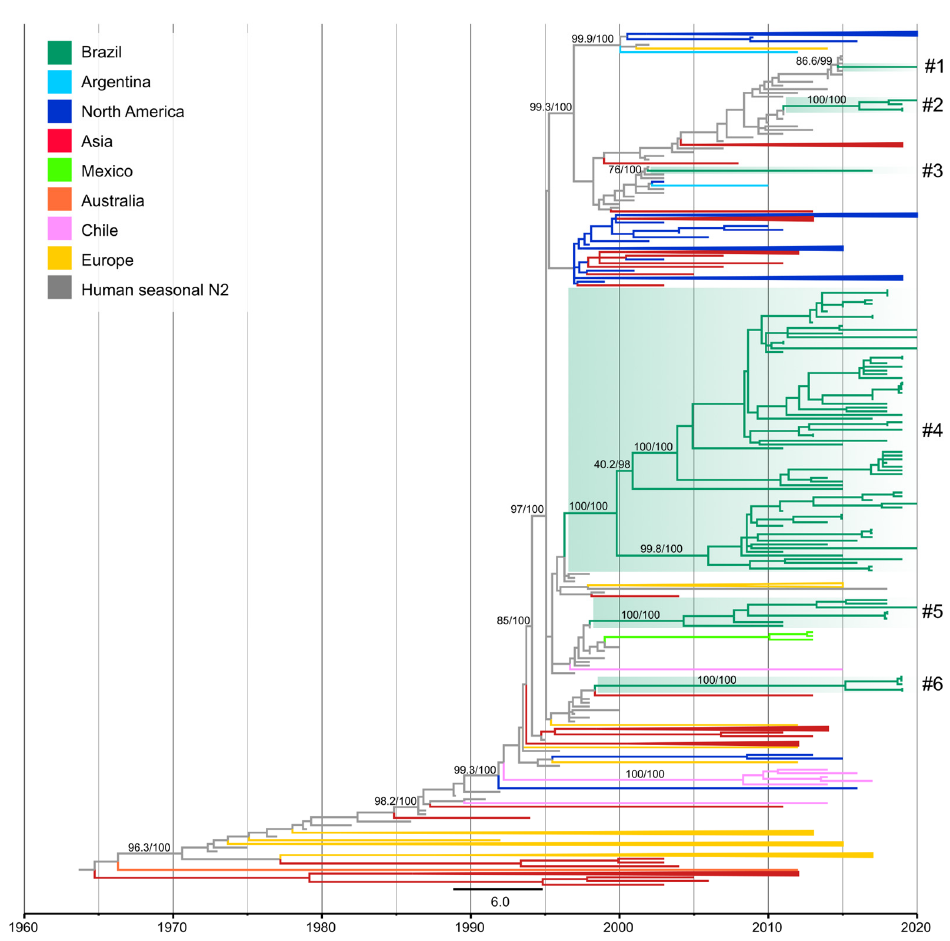
Figure 4. Time-scaled phylogeny demonstrating time of spillover of human seasonal N2 NA segments into swine in Brazil. Phylogenetic relationships of the N2 sequences from 704 human-origin H3N2 and H1N2 swine influenza virus isolates collected globally during 1991–2020, and 80 human seasonal H3N2 and H1N2 influenza viruses collected globally from humans during 1973–2020 (total dataset, n = 784 N2 sequences). Branches associated with human isolates are gray. The Brazilian clades are highlighted in green. Remaining branches related to viruses from swine are shaded by country of origin. Branch support values (aLRT/UFboot) >85 are provided for key nodes. Introductions of the segment N2 from humans into swine in Brazil are identified by the numbers with a hash “#”, as listed in Table S2.